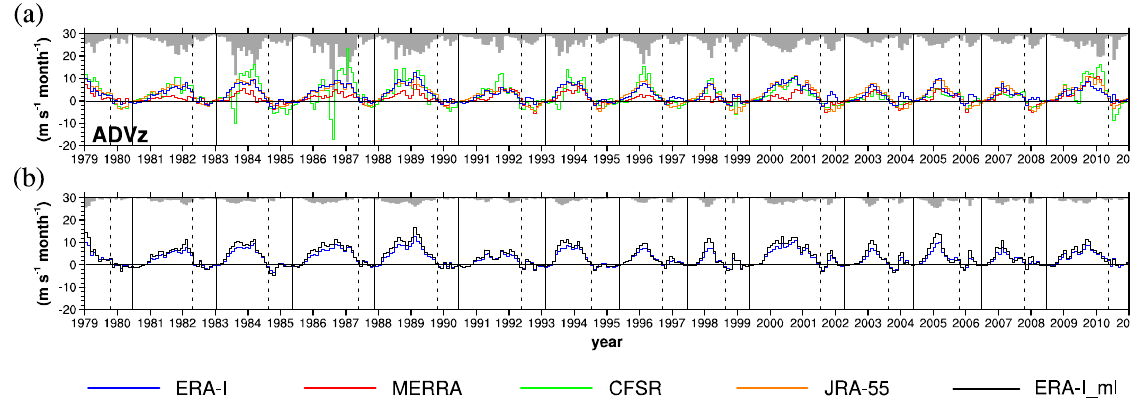
Figure 4. The same as in (a) Fig. 2 and (b) Fig. 3, except for the vertical advection of zonal wind.